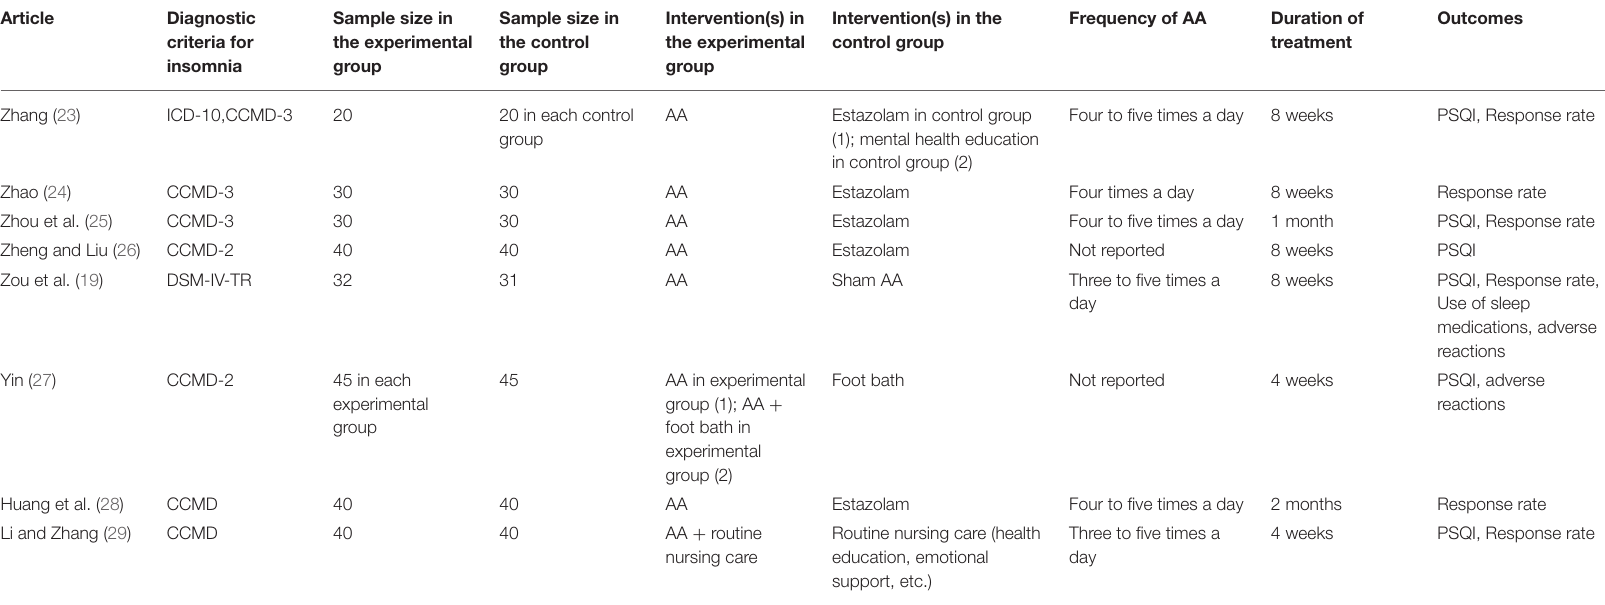
TABLE 1 | Characteristics of included